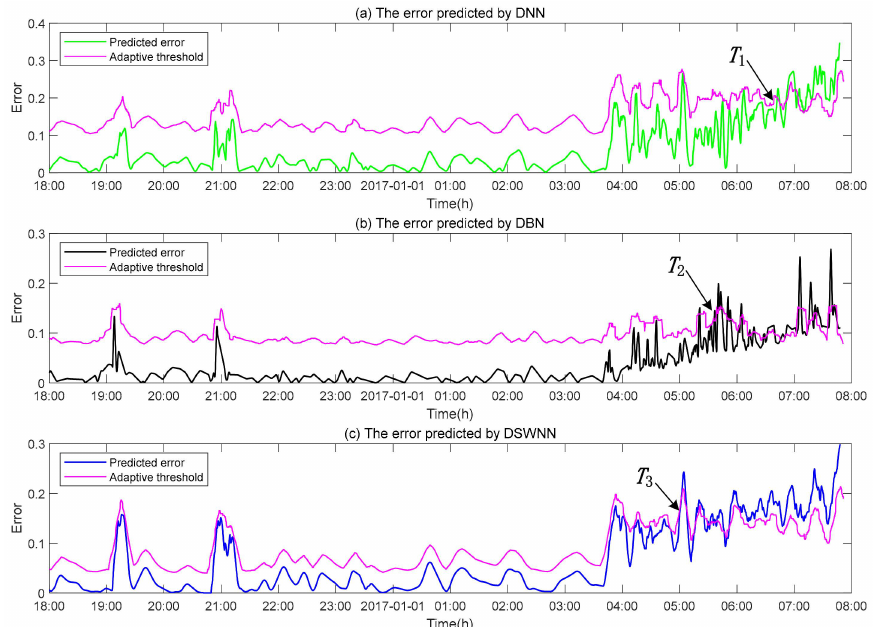
Figure 7. Fault prediction errors ( a ) by deep neural network (DNN); ( b ) by denoise auto-encoder (DAE); ( c ) by